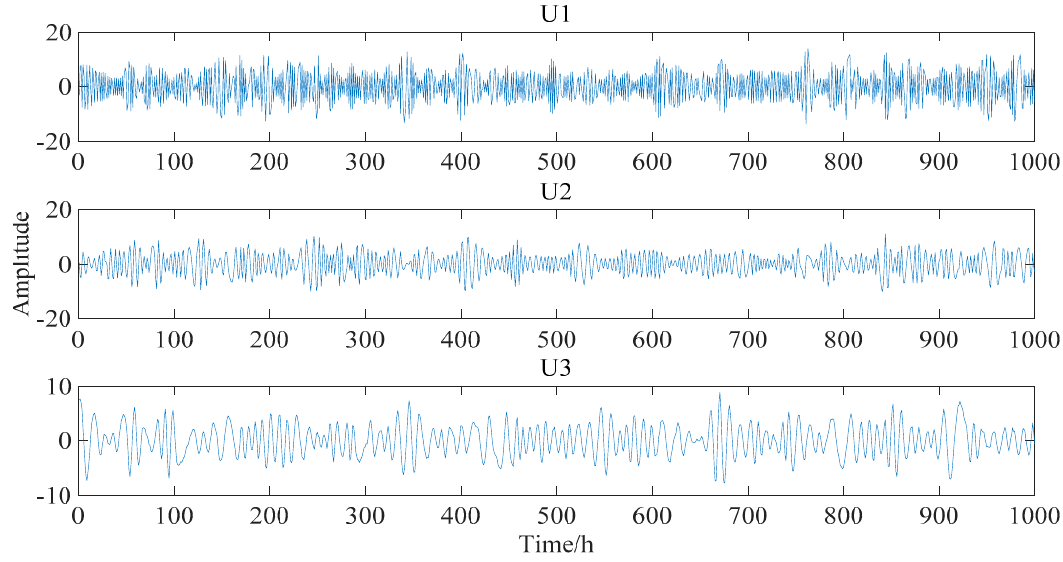
Figure 11. EEMD process.